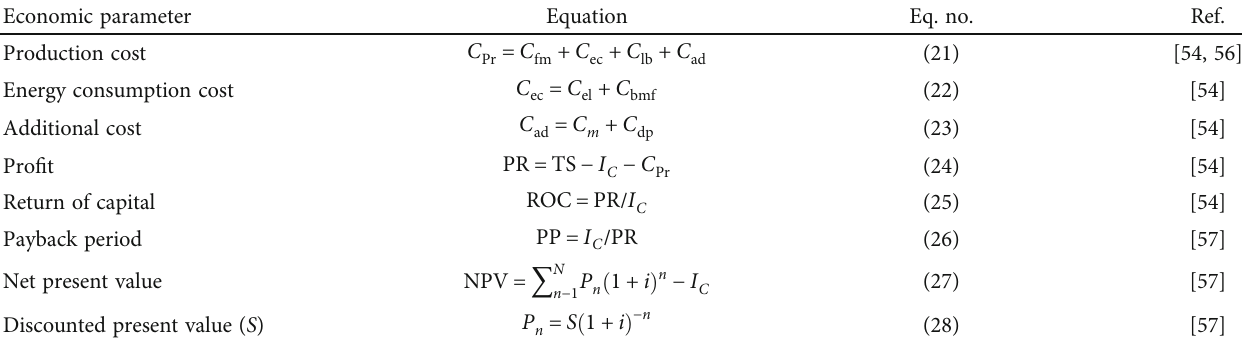
Table 5: Equations used to determine the production cost, pro fi t, payback period, and net present value of the PSBA-RMFD.